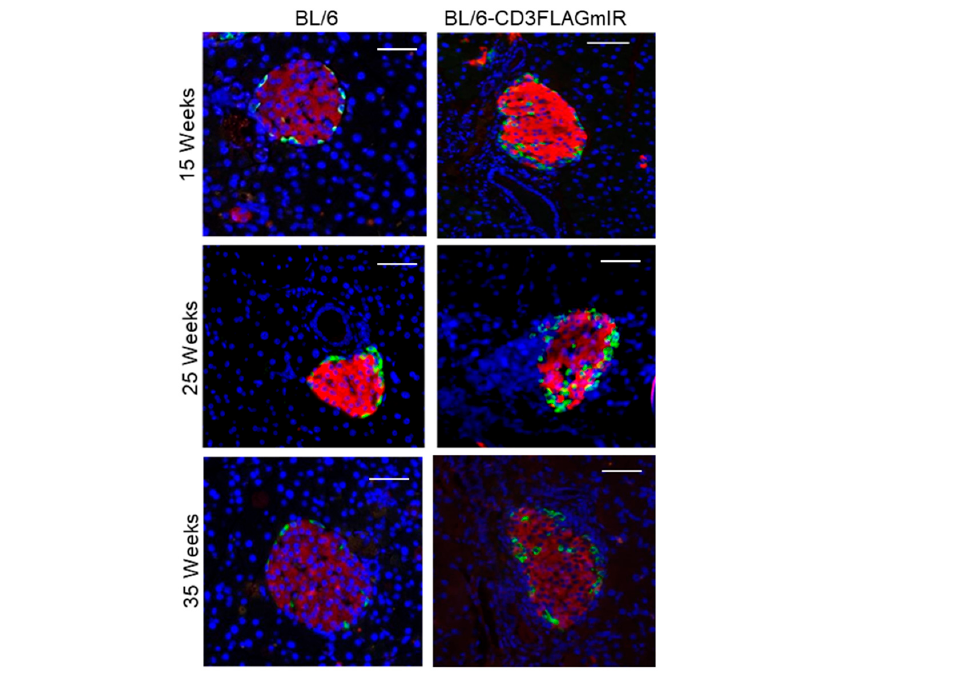
Figure 8. Islet morphology analysis by insulin (red) and glucagon (green). Immunofluorescence staining at 15, 25, and 35 weeks of age in BL/6 mice and BL/6-CD3FLAGmIR transgenic mice. ( n = 3 mice per age group). Scale bar: 300 µm.